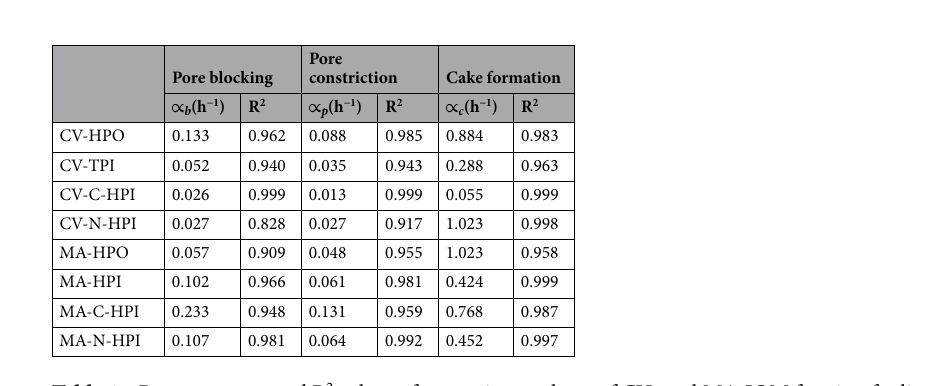
Table 1. Rate constants and R 2 values of regression analyses of CV- and MA-IOM fraction fouling.